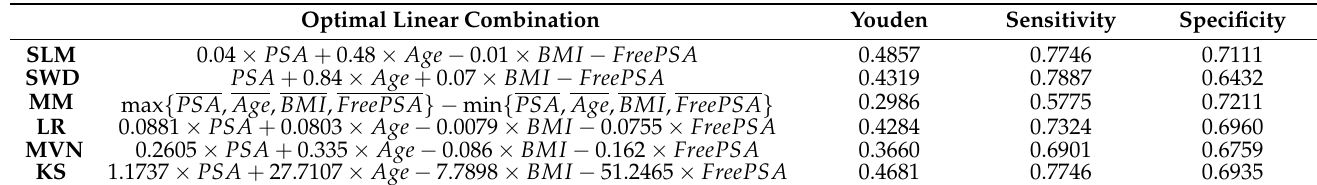
Table 21. Linear combination that maximizes the Youden index for each method. Prostate can- cer dataset.